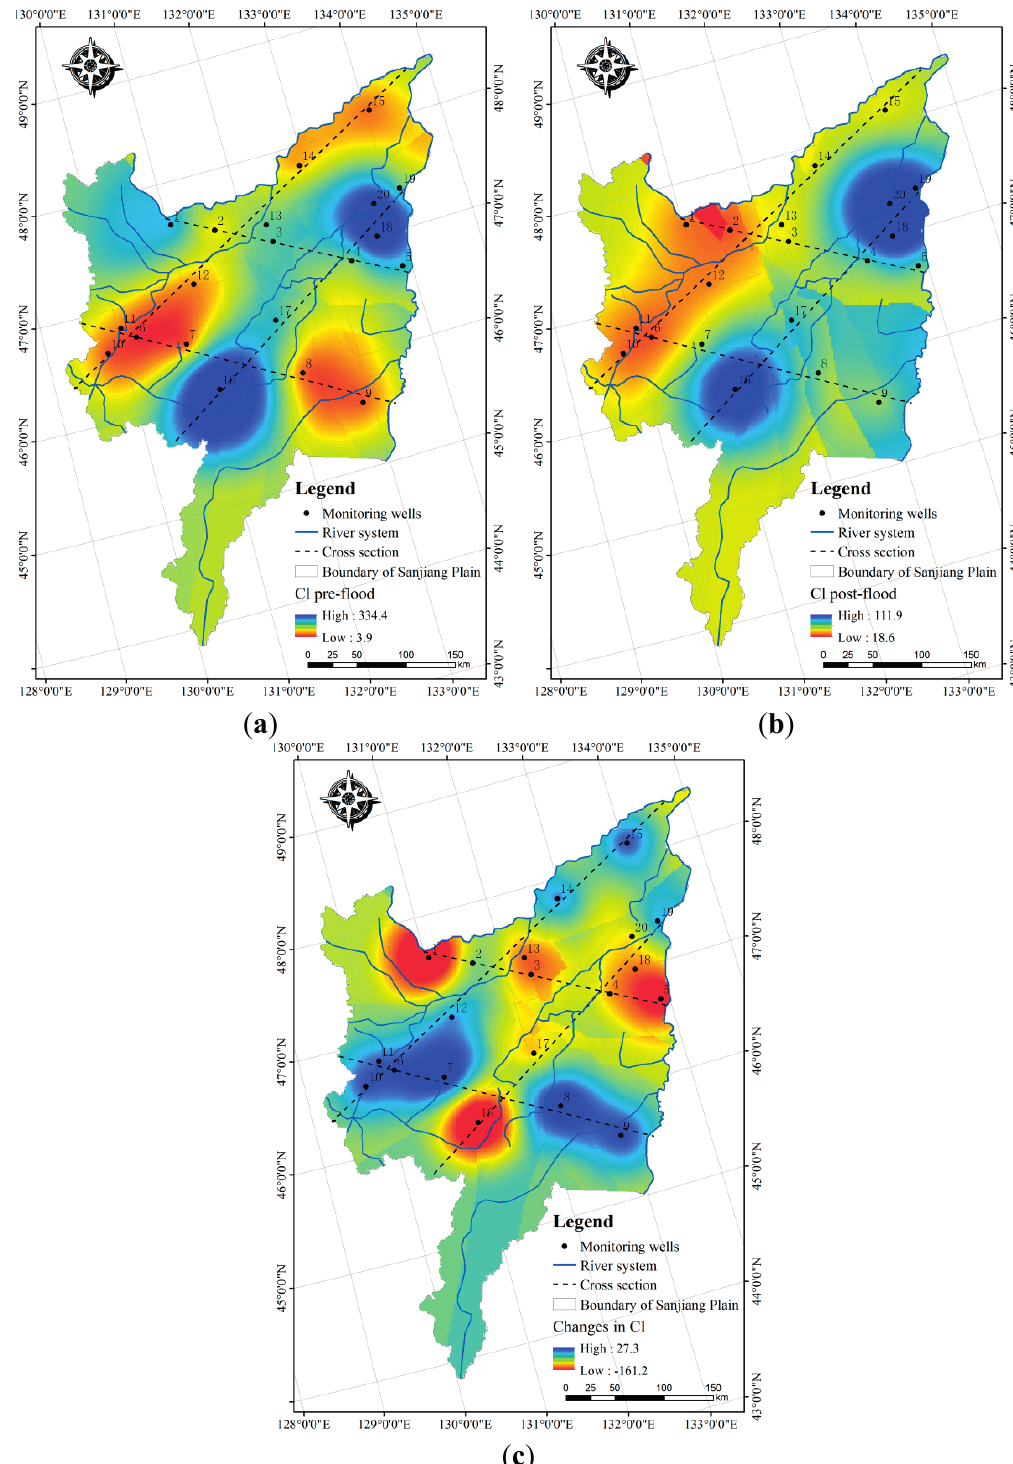
Figure 7. Changes in shallow groundwater Cl − concentration following the 2013 flood in the Sanjiang Plain, Northeast China: ( a ) pre-flood; ( b ) post-flood; and ( c ) changes between pre- and